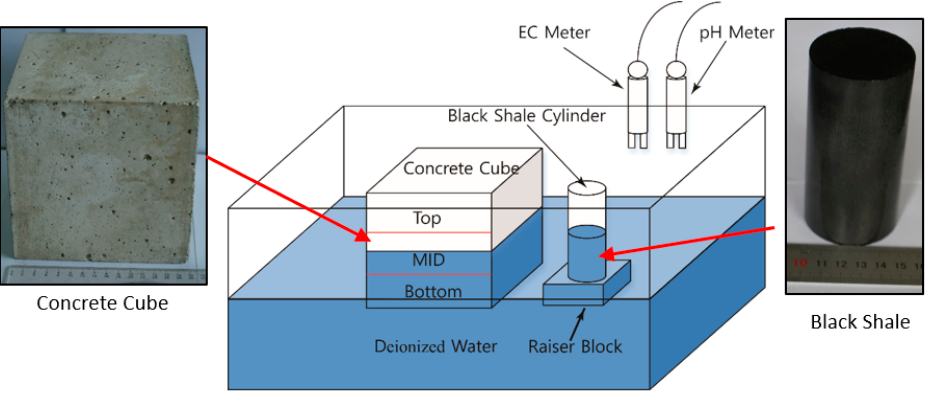
Figure 1. Schematic view of the setup of the laboratory immersion tests.